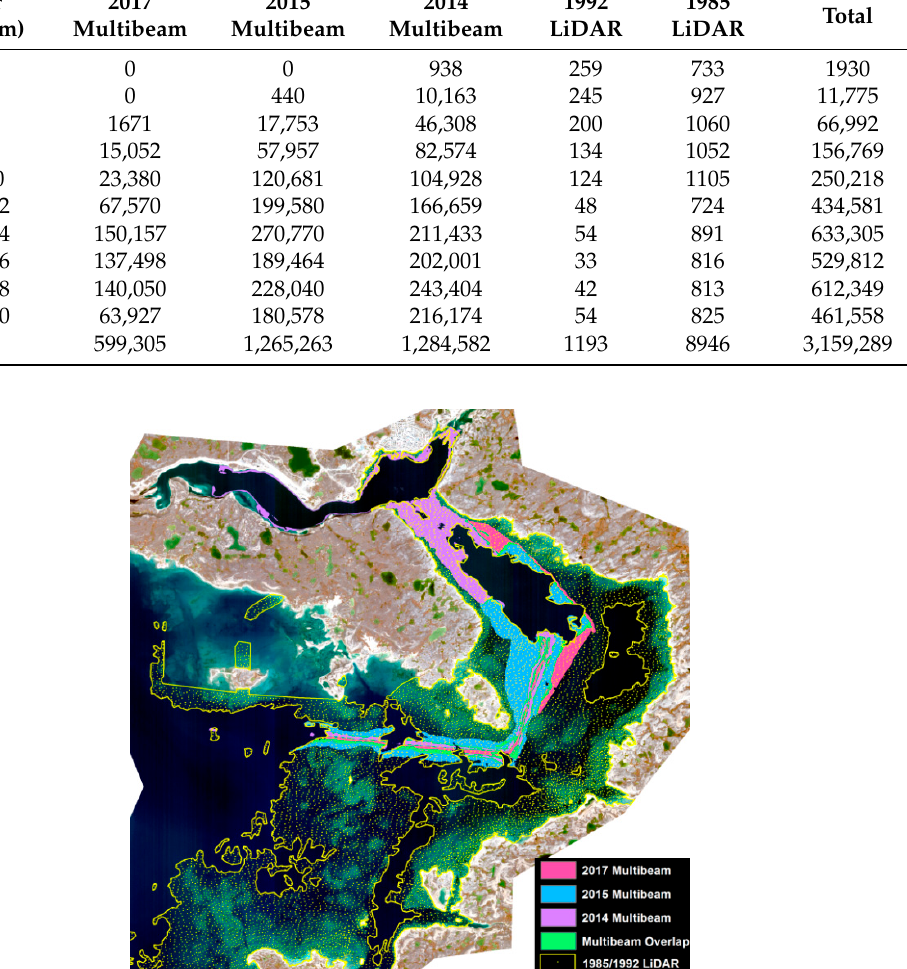
Table 2. Distribution of hydrographic survey points for water depth ranges up to 20 m.